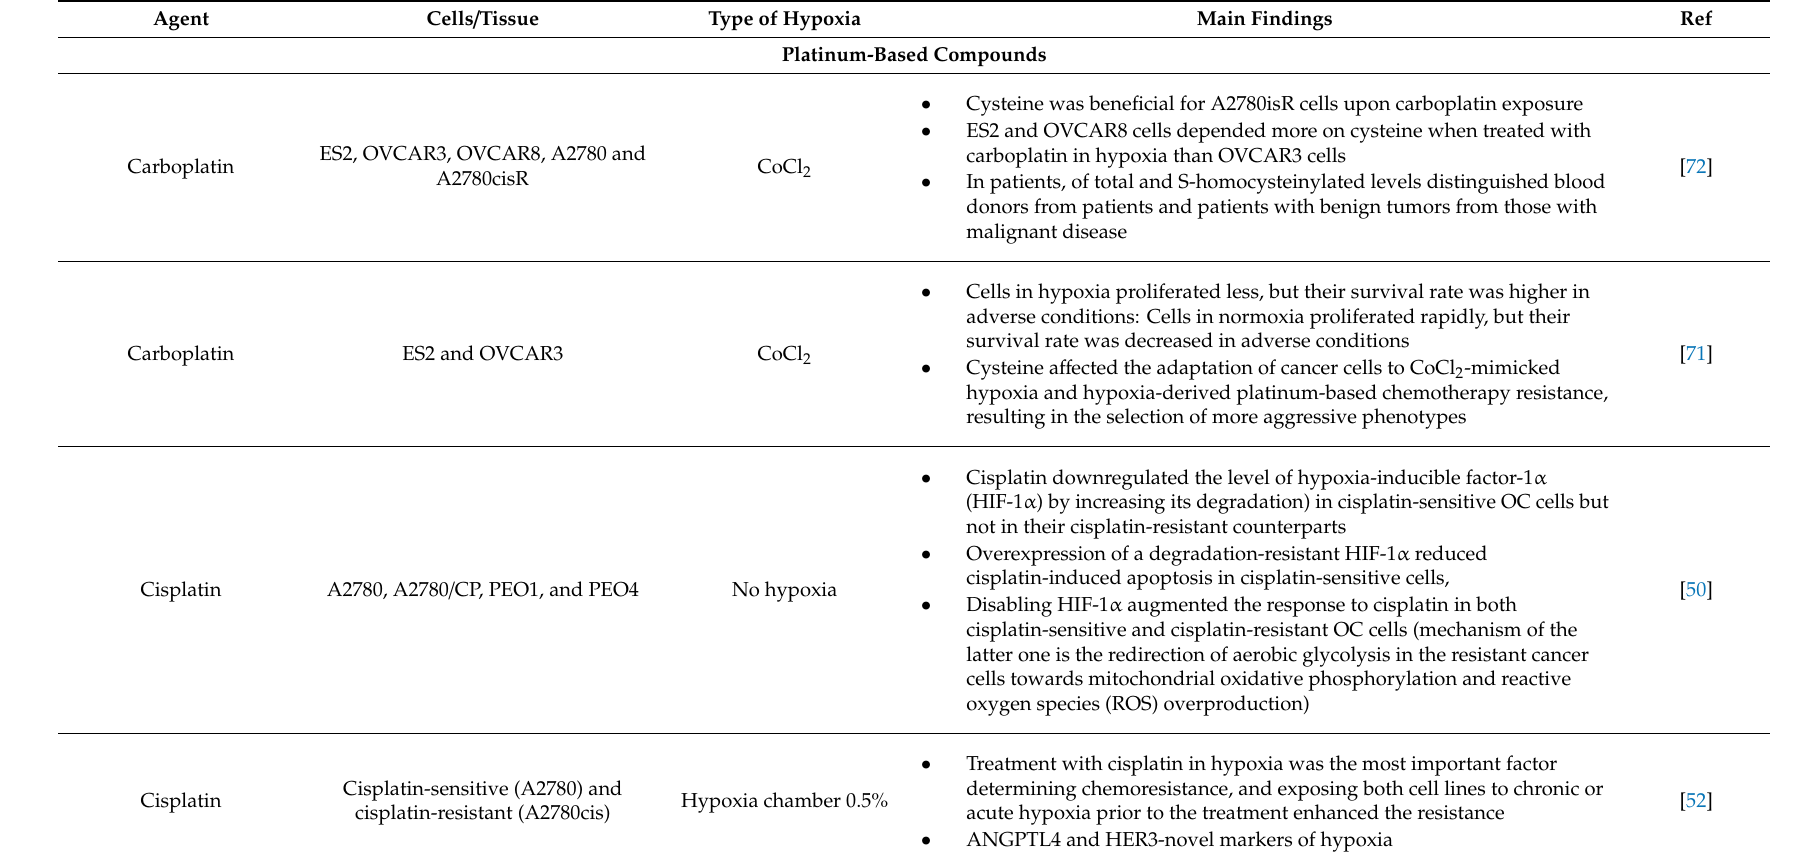
Table 2. Summary of research on ovarian cancer (OC) cells reaction to chemotherapy treatment in hypoxia or related to the hypoxia